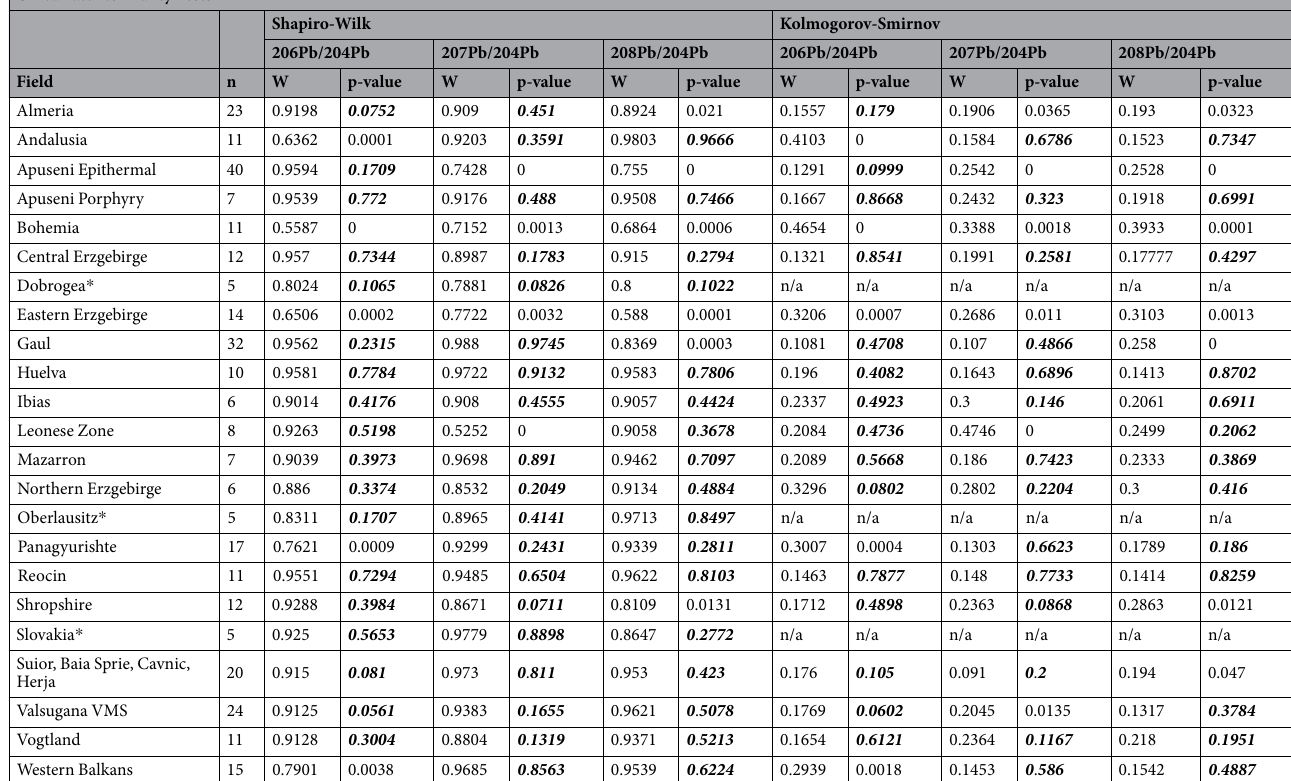
Table 1. Univariate normality tests for all ore bodies used to construct models in this work. For both Shapiro- Wilk and Kolmogorov-Smirnov tests, W indicates the associated test statistic, whilst the p-value indicates the significance of this statistic. Those highlighted in bold and italicised are significant at 5%, indicative of a normal distribution. Raw data may be found in Tables SI 1–3. * Insufficient data points for Kolmogorov-Smirnov